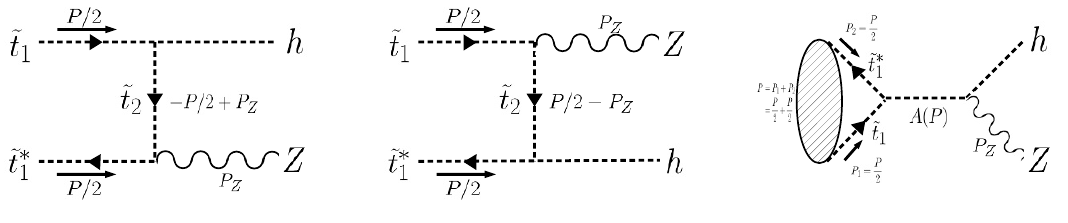
Figure 1 . Feynman diagrams for the stoponium decaying into Zh via the t , u , s channels from the left to the